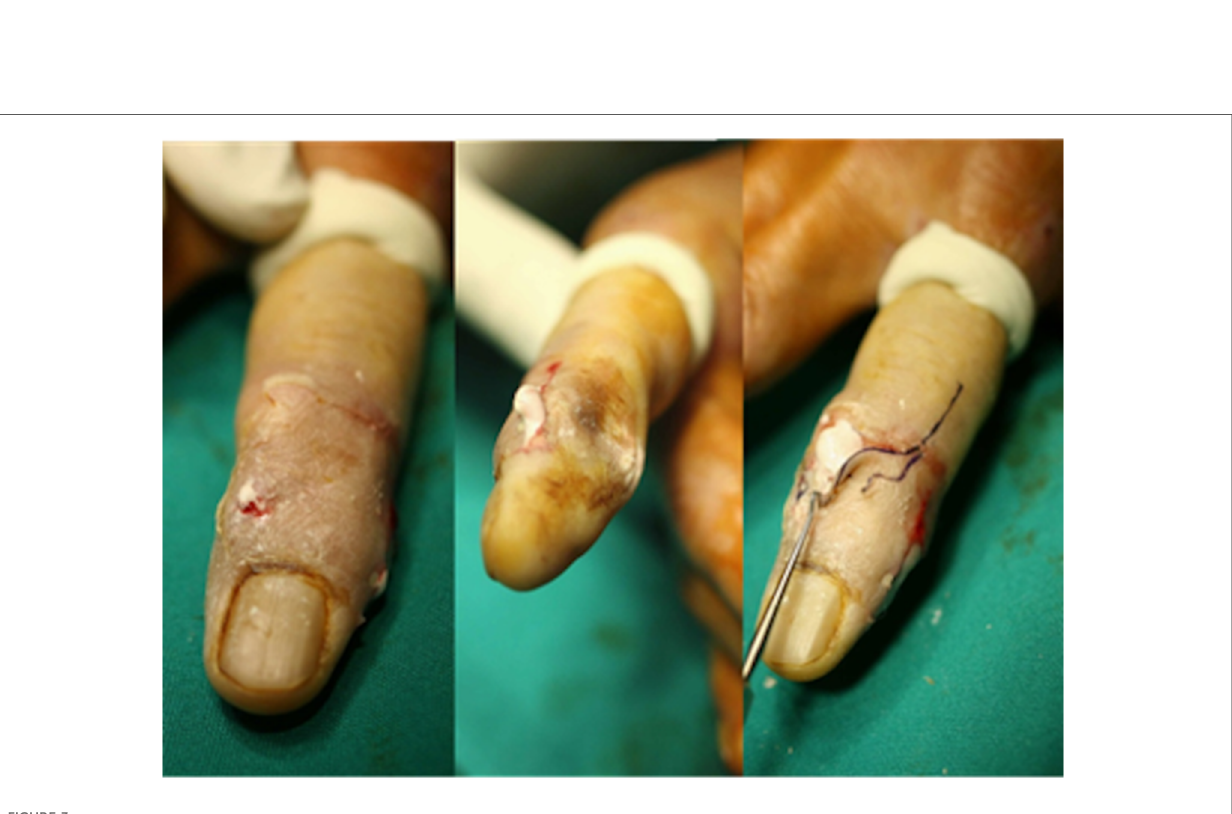
FIGURE 3 The calci fi cations during the